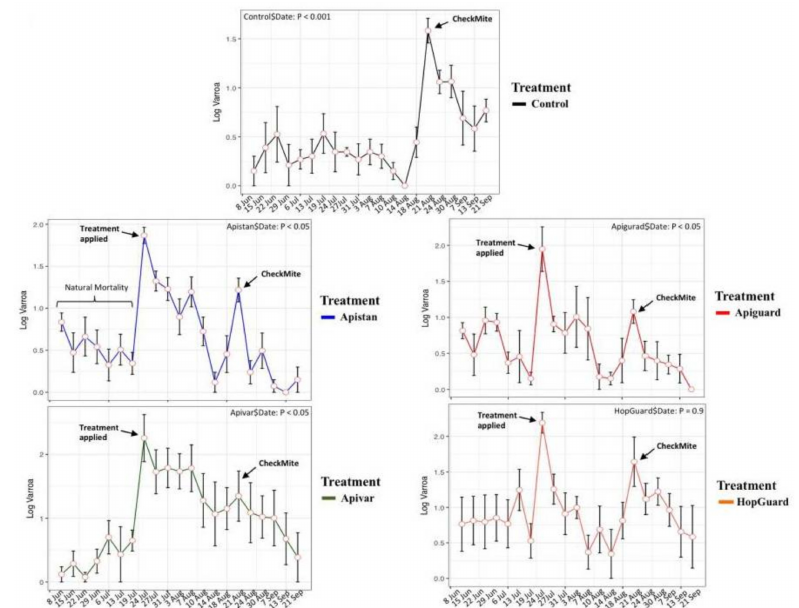
Figure 5. Overview of the Varroa population dynamics and the Varroa mortalities after specific acaricide treatment within colonies of the four treatment groups and control. Acaricidal treatments were applied on 19 July in all of the groups except the control, and a final CheckMite ® treatment was applied in all of the groups on 18 August, so as to kill the remaining mites in a hive. The period between 31 May and 19 July is, for all of the groups, a monitoring period to assess the natural Varroa mortality, in which no acaricides were applied.